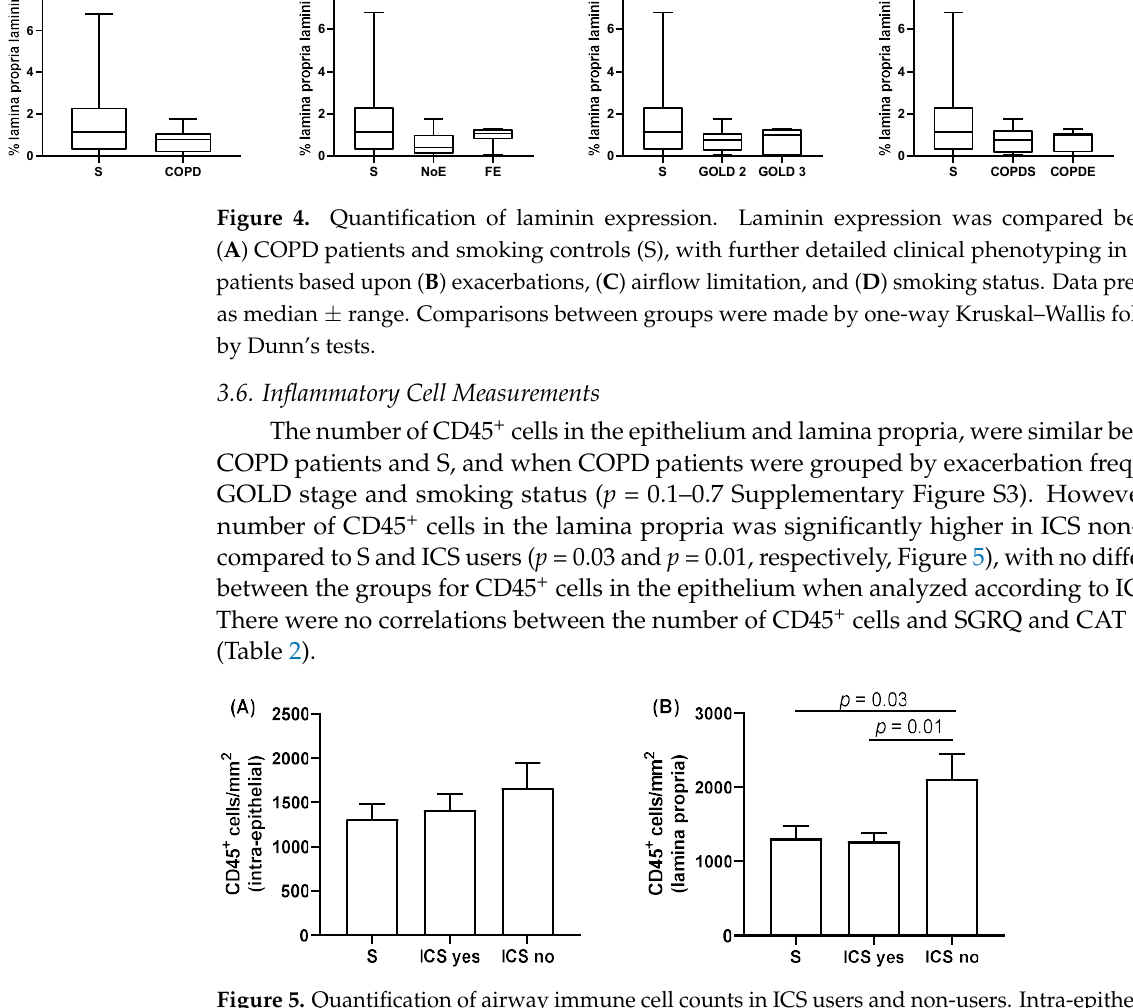
Figure 5. Quantification of airway immune cell counts in ICS users and non-users. Intra-epithelial ( A ) and sub-mucosal ( B ) CD45 + immune cells numbers were compared between ICS users (ICS yes), ICS non-users (ICS no), and smoking controls (S). Data presented as mean + SEM. Comparisons between groups were made by one-way ANOVA followed by Tukey’s multiple comparison test.